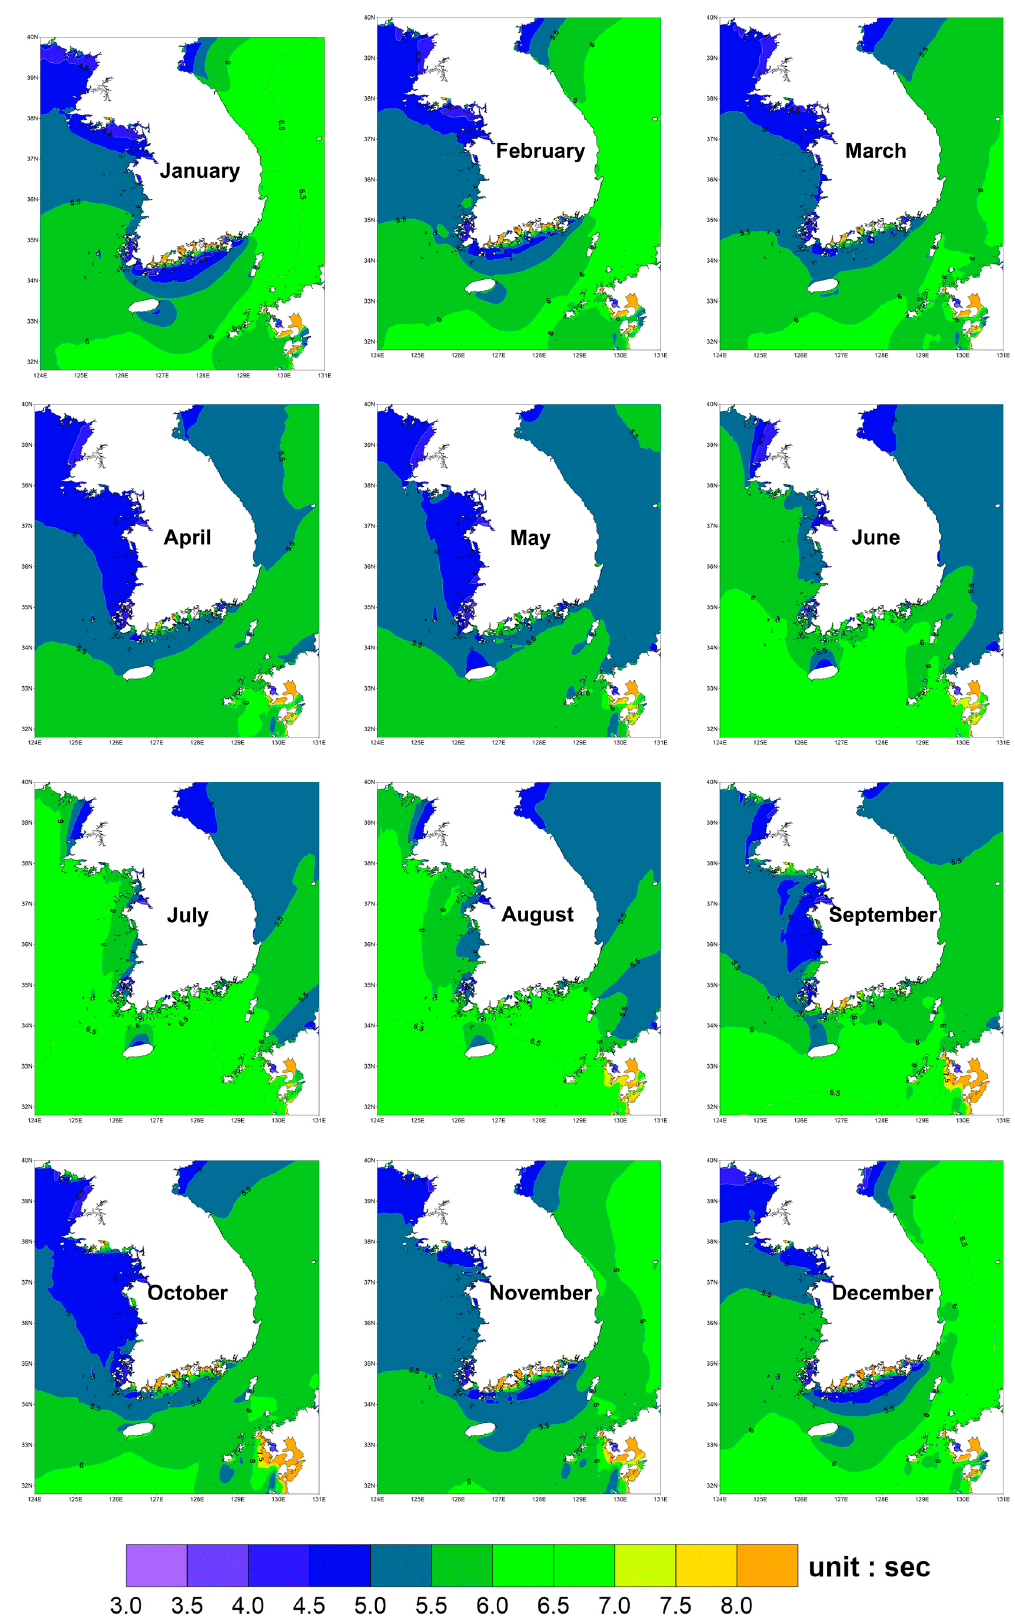
Figure 15. Monthly averaged wave period around the Korean Peninsula over